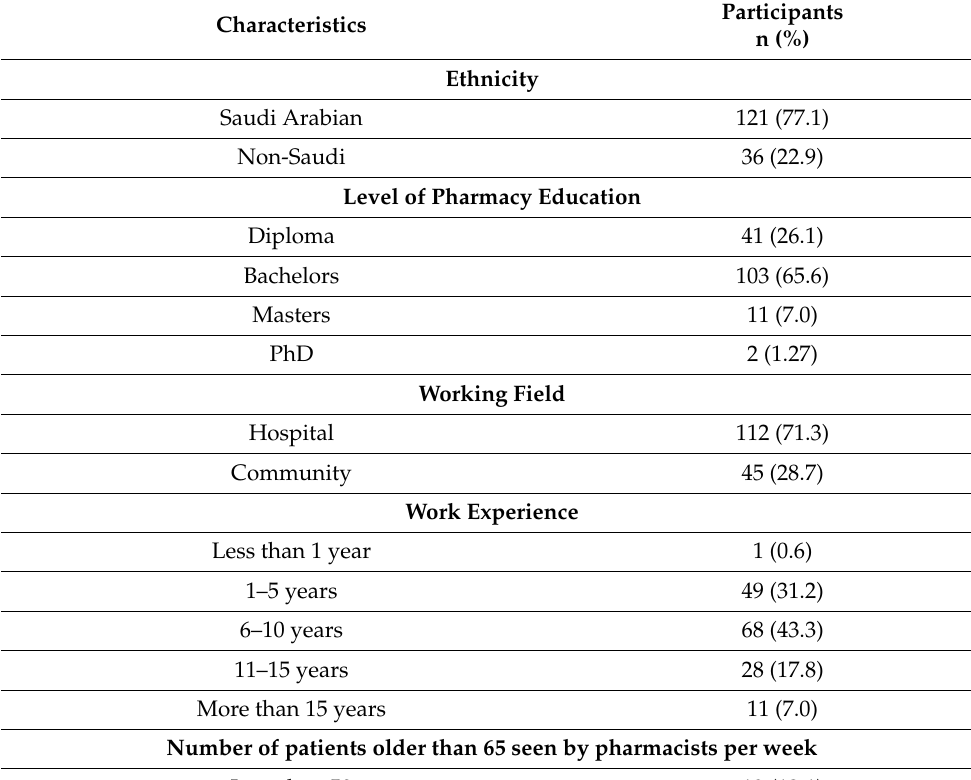
Table 1. Characteristics of the study population (N =